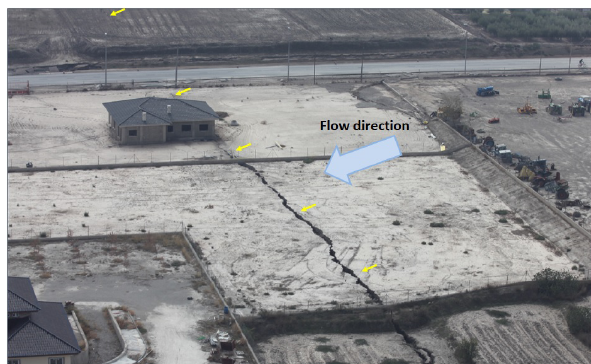
Figure 3. Ground-penetrating radar along the ditch beside the road.